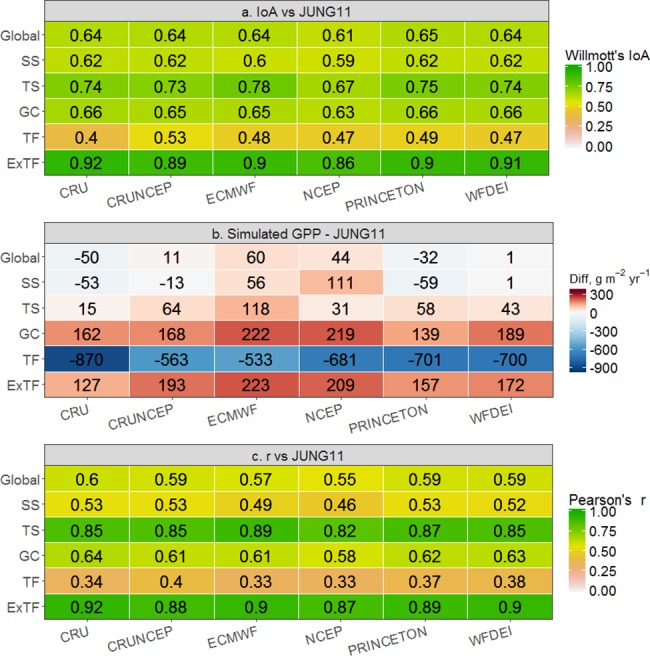
Comparison of monthly IoA, annual mean GPP and monthly temporal correlation during 1982–2010 as estimated by LPJ-GUESS forced by six climate datasets versus the observation-based GPP product JUNG11.Panel (a) shows the IoA, panel (b) shows the average difference and the last panel (c) shows the temporal correlation coefficient between simulated GPP and observations for each land cover class: global; semi-arid ecosystems (SS); tundra and arctic shrub land (TS); grasslands and land under agriculture (GC); tropical forest (TF); extra-tropical forest (ExTF) includes boreal and temperate. The map of land cover classes can be seen in S1 Fig. The spatial distribution of GPP magnitude can be found in S2 Fig.